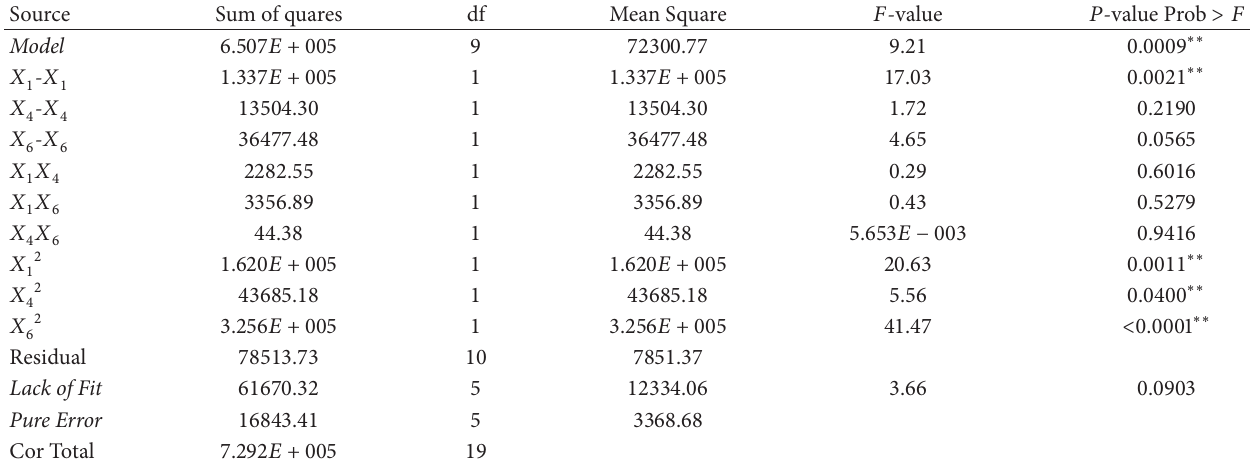
Table 7: ANOVA for response surface quadratic polynomial model for carbon sources and inorganic salts.